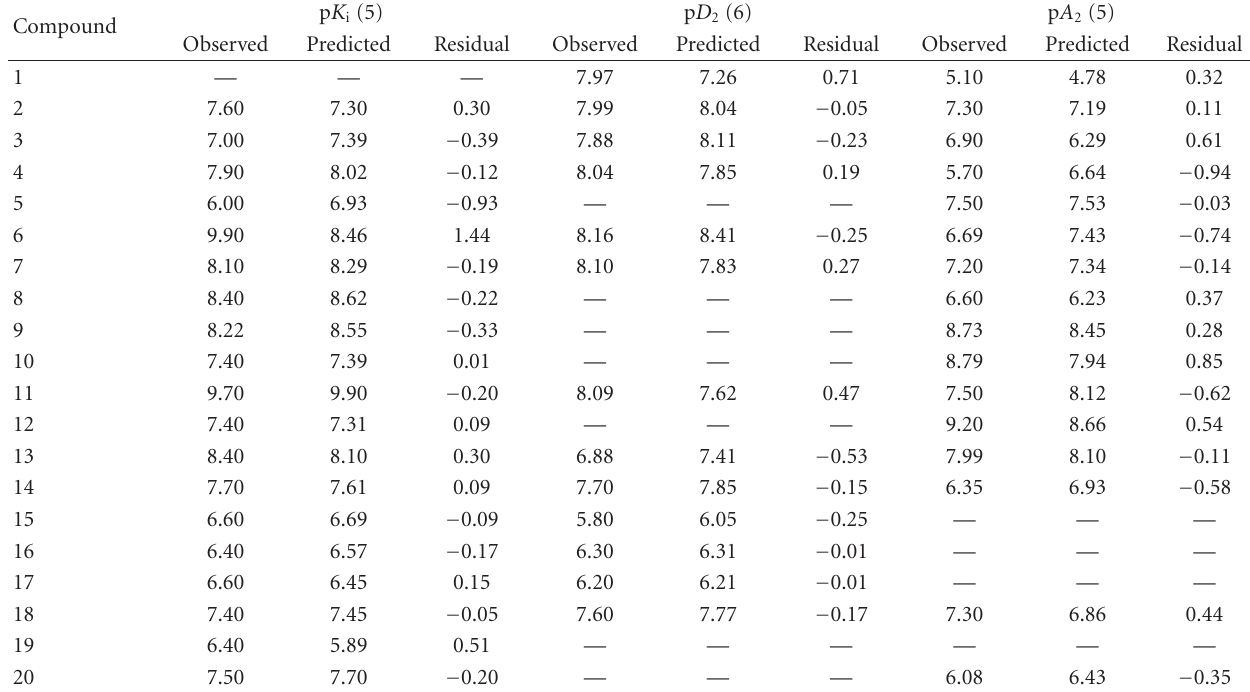
Table 7: Observed and predicted values of activity for Equations (5), (6), and